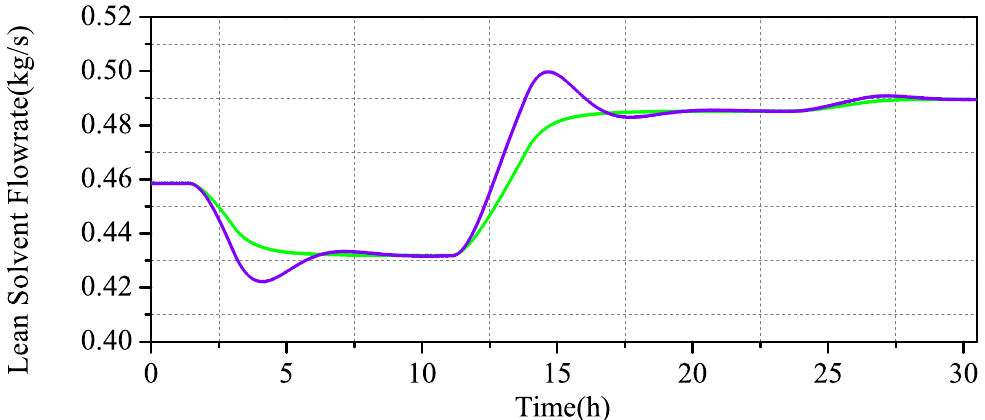
Figure 13. Scenario 2: Comparison of MPC and PID simulation of the CO 2 capture